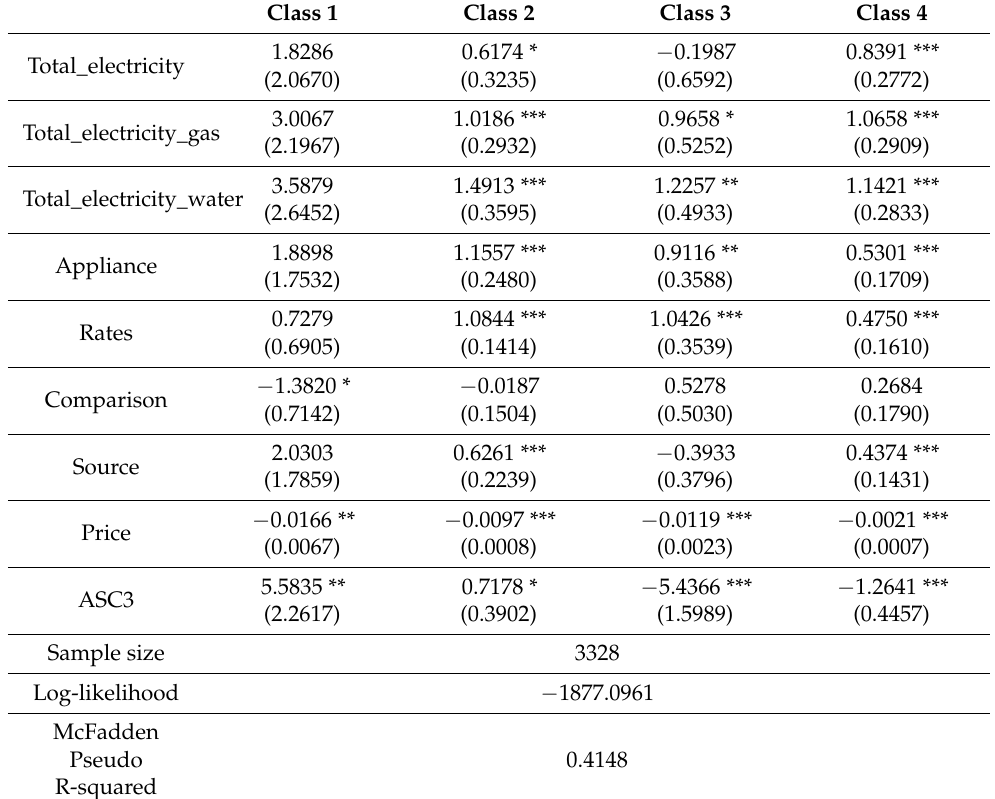
Table 5. Utility function.